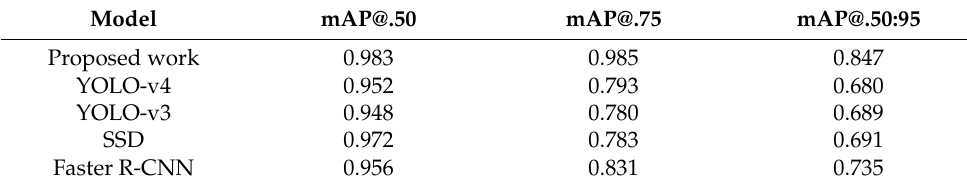
Table 10. The mAP comparison experiments of different models in all